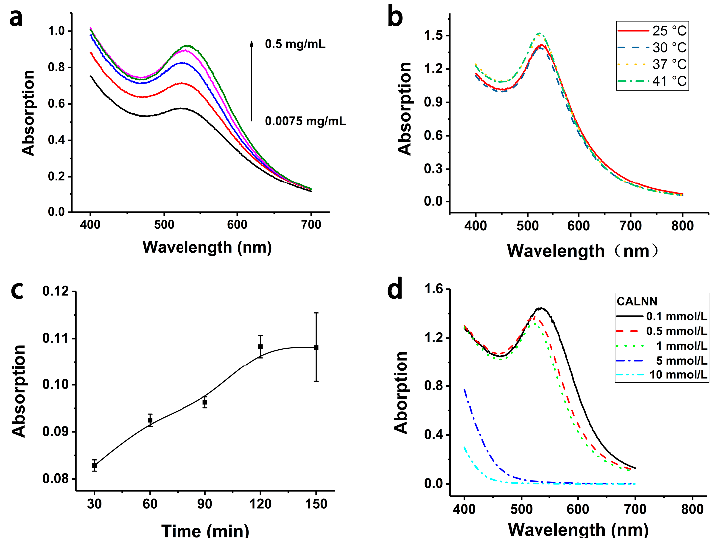
Figure 3. ( a ) UV–vis absorption spectra of the product prepared with di ff erent concentrations of tyrosine Figure 3. ( a ) UV − vis absorption spectra of the product prepared with different concentrations of or ( b ) at di ff erent temperature. ( c ) The absorption of AuNPs at 520 nm changes with the reaction time. tyrosine or ( b ) at different temperature. ( c ) The absorption of AuNPs at 520 nm changes with the ( d ) UV–vis absorption spectra of AuNPs prepared with di ff erent concentrations of reaction time. ( d ) UV–vis absorption spectra of AuNPs prepared with different concentrations of CALNN.